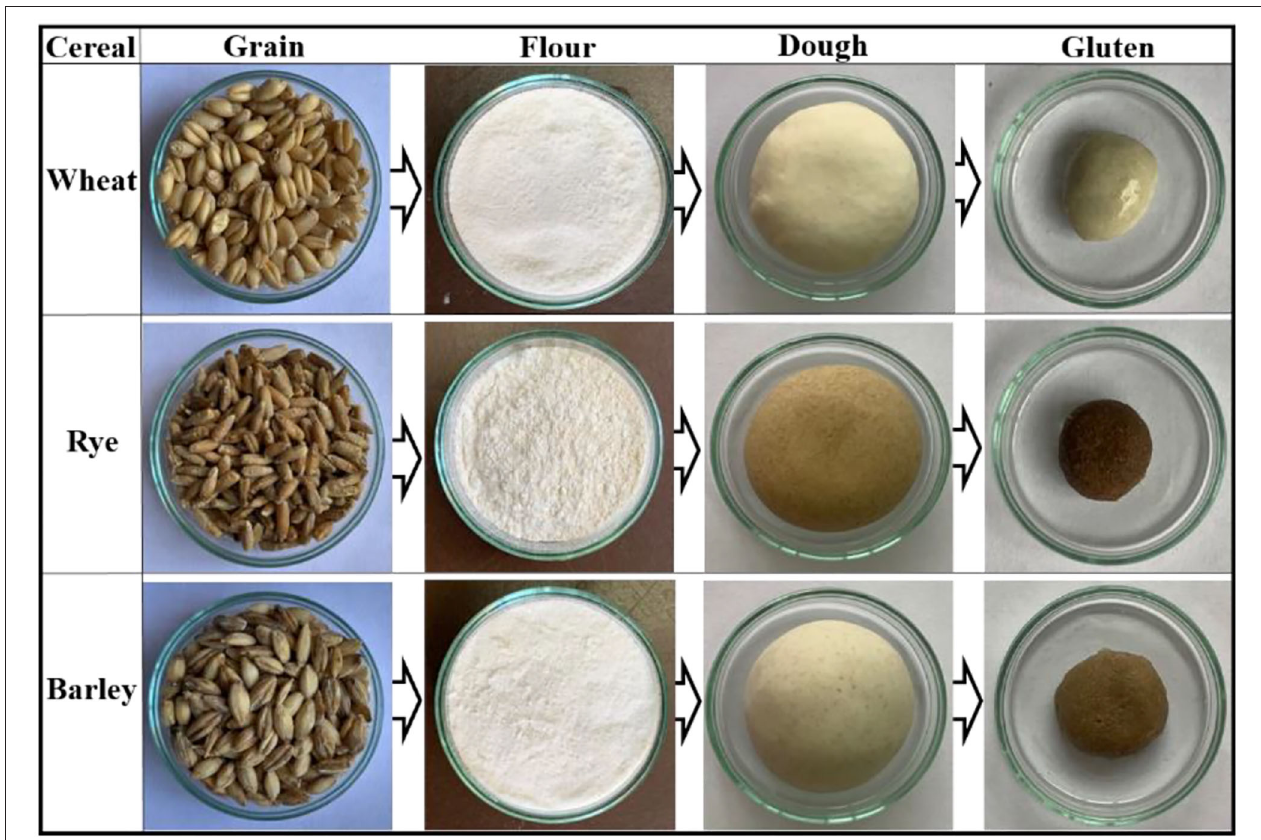
FIGURE 1 | Schematic representation showing the preparation of flour, dough, and gluten from wheat (HPW-142), rye (MCTLG-1), and barley (BH-393) cultivars.